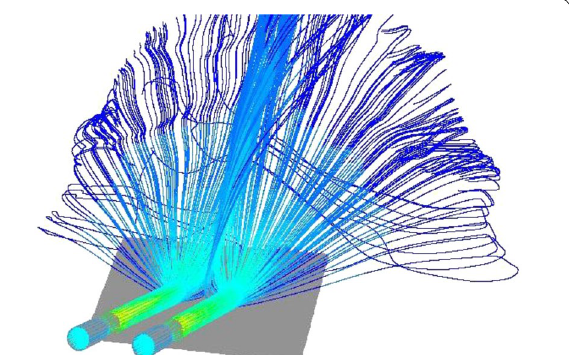
Figure 21 Static temperature contour of 150 °C in computational domain